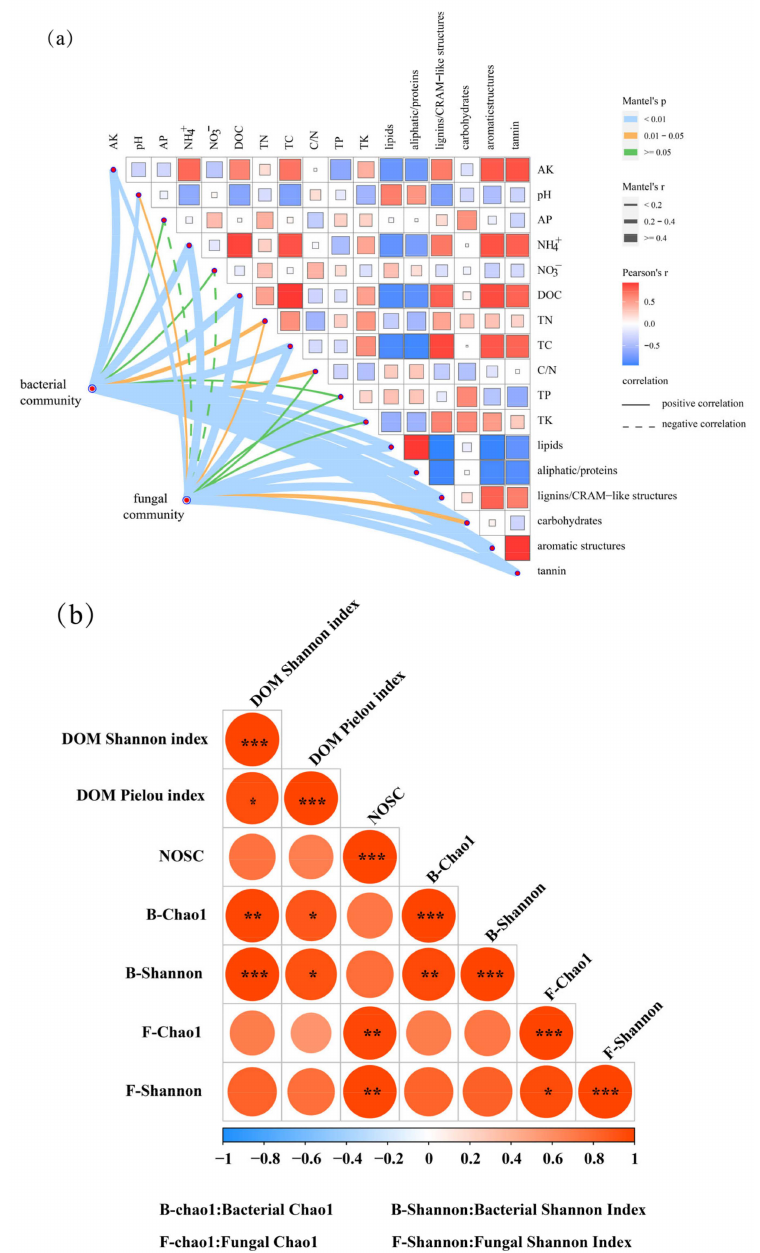
Figure 7. Mantel test between soil chemistry, soil dissolved organic matter, and soil microbial communities (bacterial and fungal communities) ( a ) AP: available phosphorus; AK: available potas- sium; DOC: dissolved organic carbon; TC: total carbon; TN: total nitrogen; TP: total phosphorus; TK: total potassium; C/N: ratio of total carbon to total nitrogen; NO 3 − : nitrate nitrogen; NH 4 +